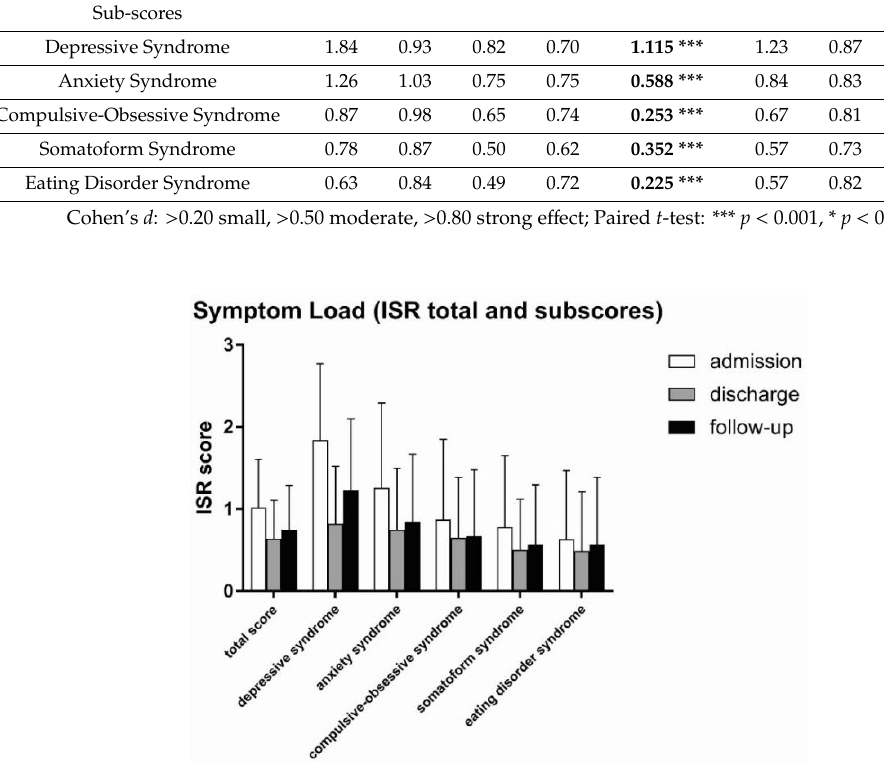
Figure 3. Symptom loads (ISR total score and sub-scores) at admission, discharge, and follow-up. Patients undergoing multimodal intervention at the Traditional Chinese Medicine (TCM) Hospital had remarkably lower symptom load regarding ISR total score and the sub-scores “depressive syndrome” and “anxiety syndrome”. This positive and beneficial effect was also observed for the sub-scores “compulsive-obsessive syndrome”, “somatoform syndrome”, and “eating disorder syndrome”, but to a lesser degree.